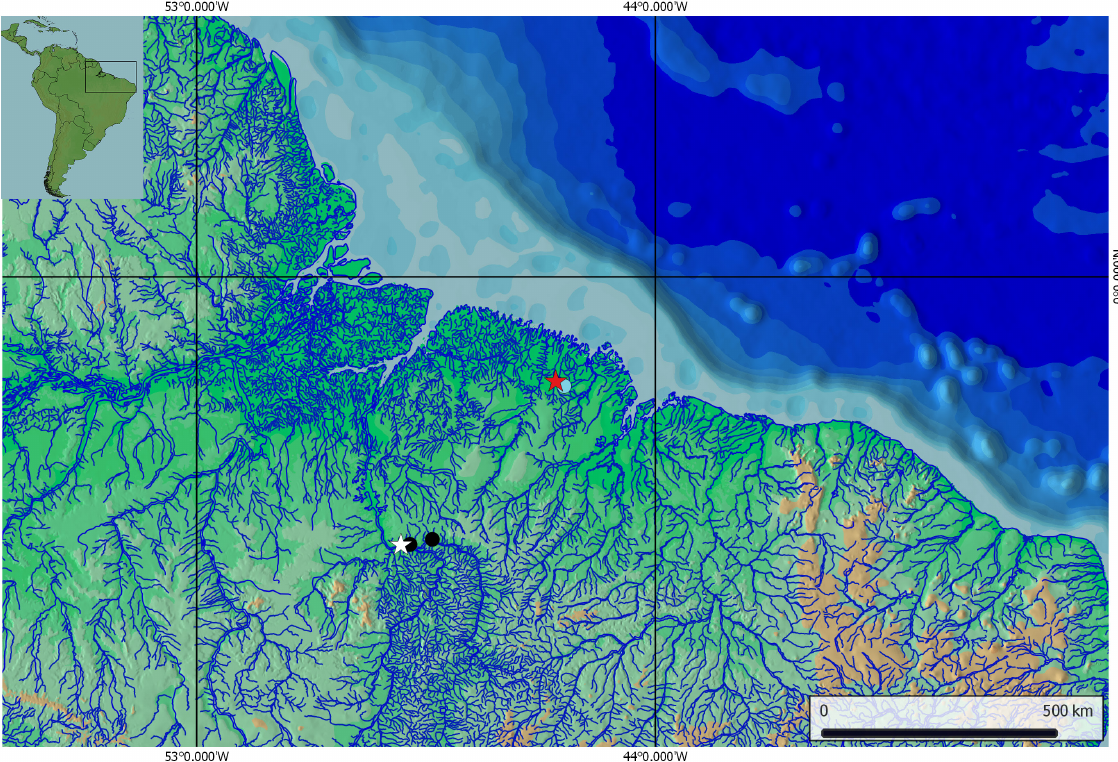
Fig. 3. Geographical distribution of Hyphessobrycon frickei Guimarães, Brito, Bragança, Katz & Ottoni sp. nov. and H. geryi Guimarães, Brito, Bragança, Katz & Ottoni sp. nov. Red star denotes holotype and blue circle denotes paratypes of H. frickei Guimarães, Brito, Bragança, Katz & Ottoni sp. nov. whereas white star denotes holotype and the black circles denote paratypes of H. geryi Guimarães, Brito, Bragança, Katz & Ottoni sp.